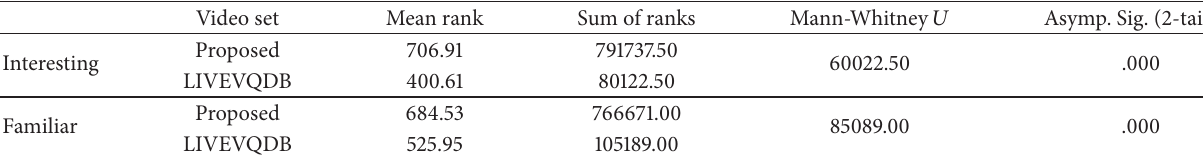
Table 3: Comparison of cognitive dimensions by the two sets.